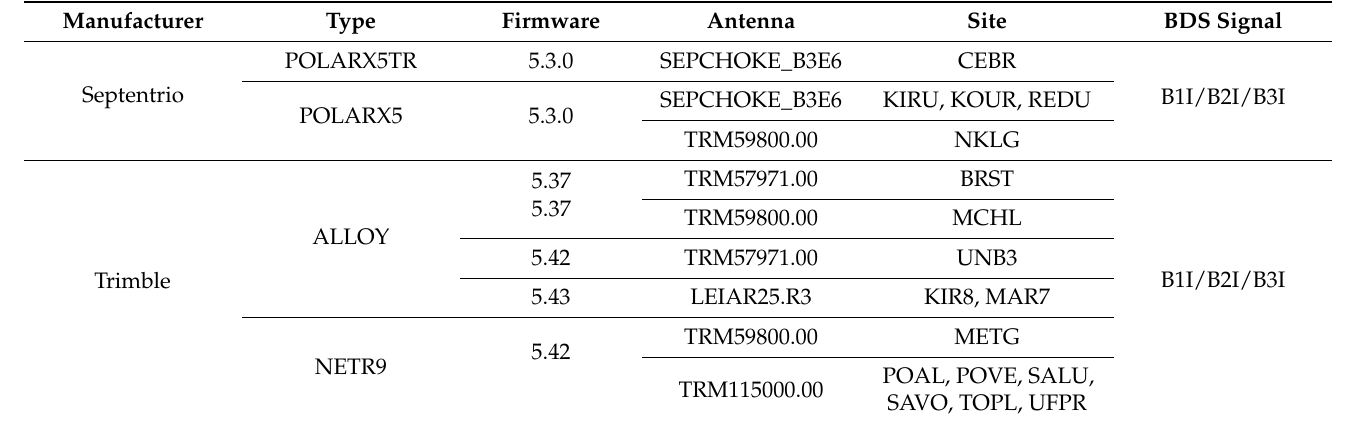
Figure 1. Distribution of experiment stations. SEPT, Septentrio. Table 2. Experimental site information (October to December